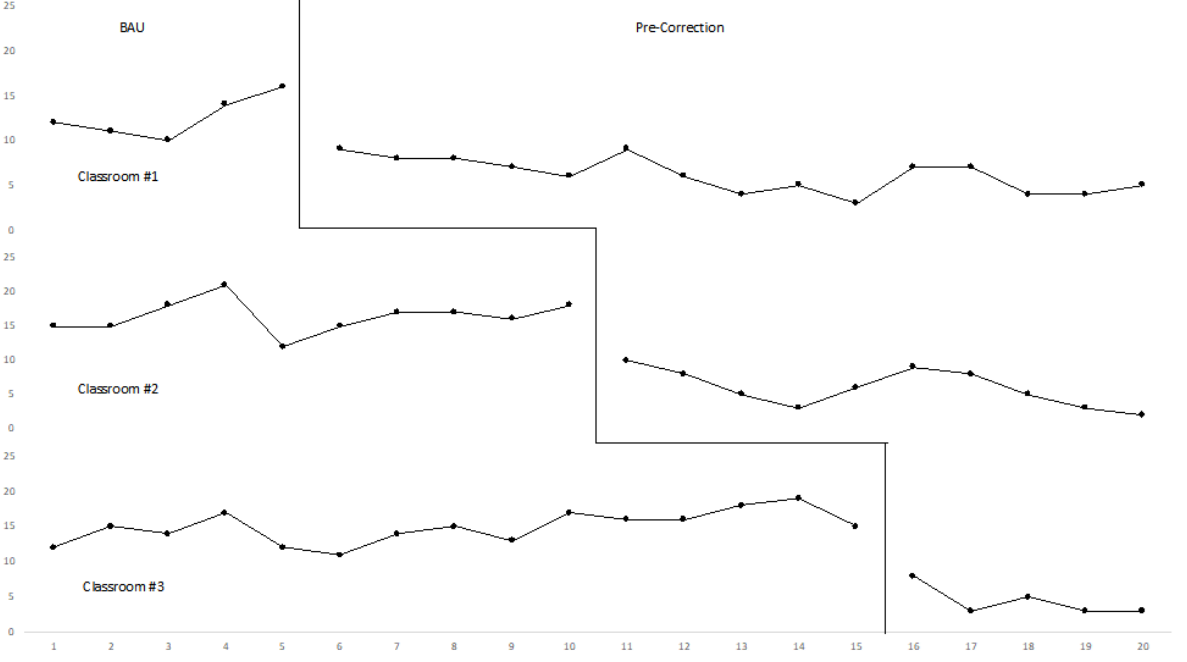
Figure 4. Visual Display of Class Data Collected Using a Multiple Baseline Across Classrooms Design: Instances of Disruptive